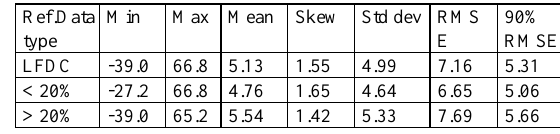
Table 7. Elevation difference statistics for the coal mine area for Jan 10, 2013 TanDEM-X